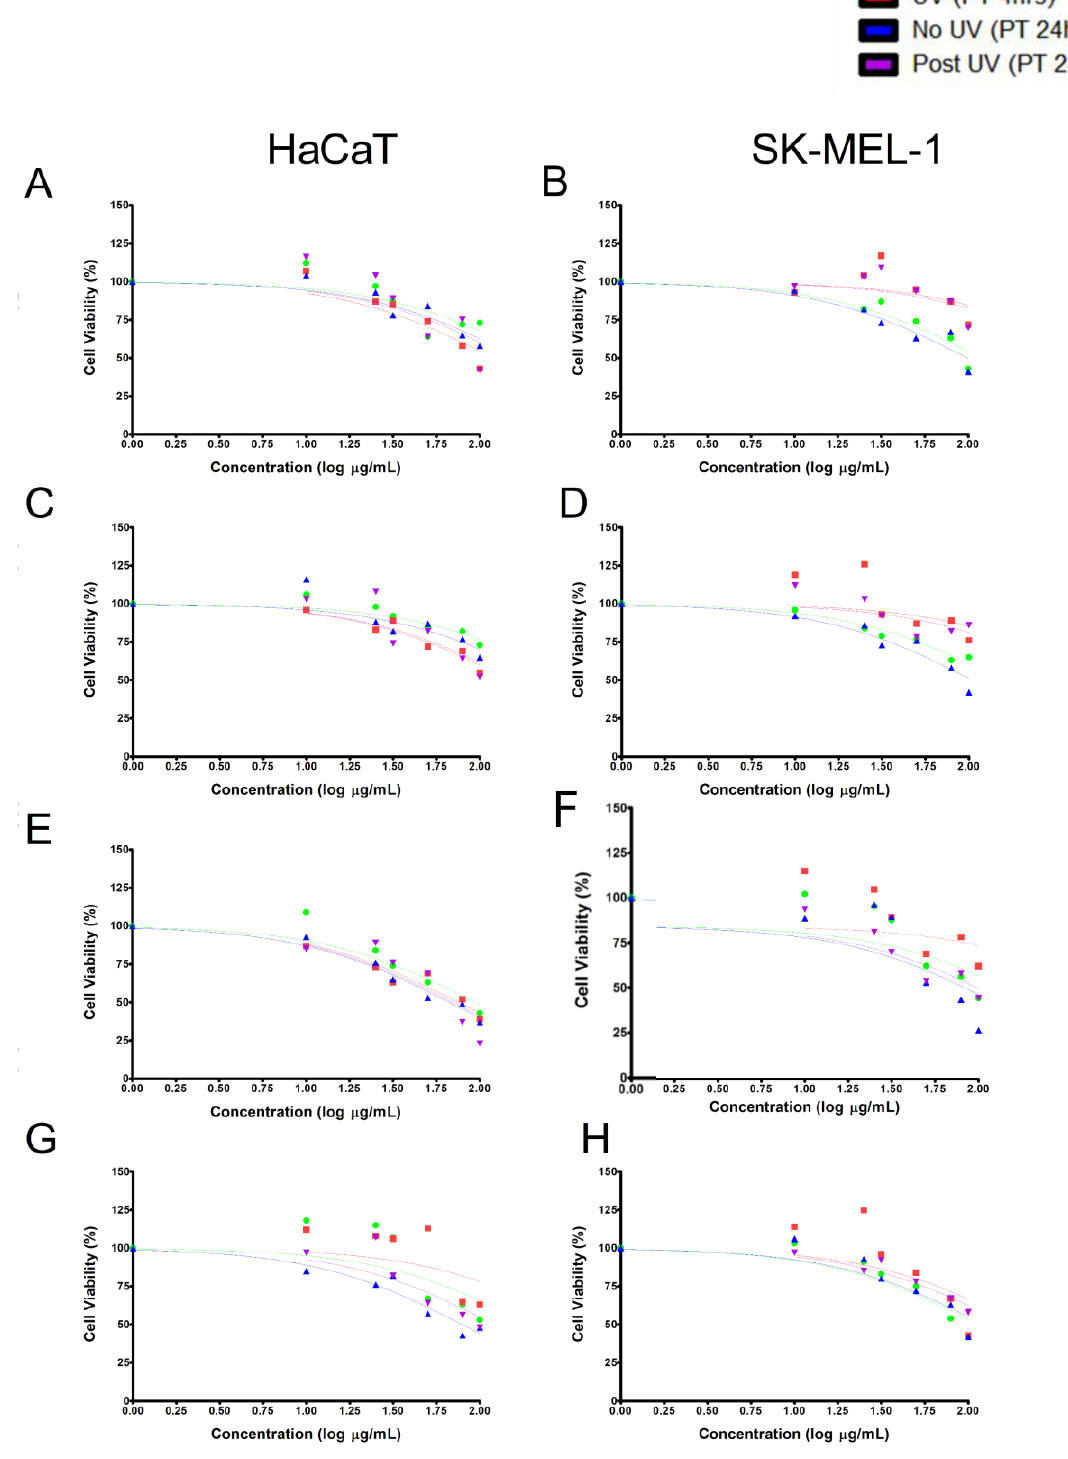
Figure 3. Effect of the tested samples pre-exposure [4- and 24-h; TE ( A , B ); compound 1 ( C , D ); compound 2 ( E , F ); compound 3 ( G , H )] on UVB irradiation in HaCaT and SK-MEL-1 cells. The MTT cytotoxicity curve alluded to time and dose-dependent cytotoxic effects by the tested samples at higher concentrations.